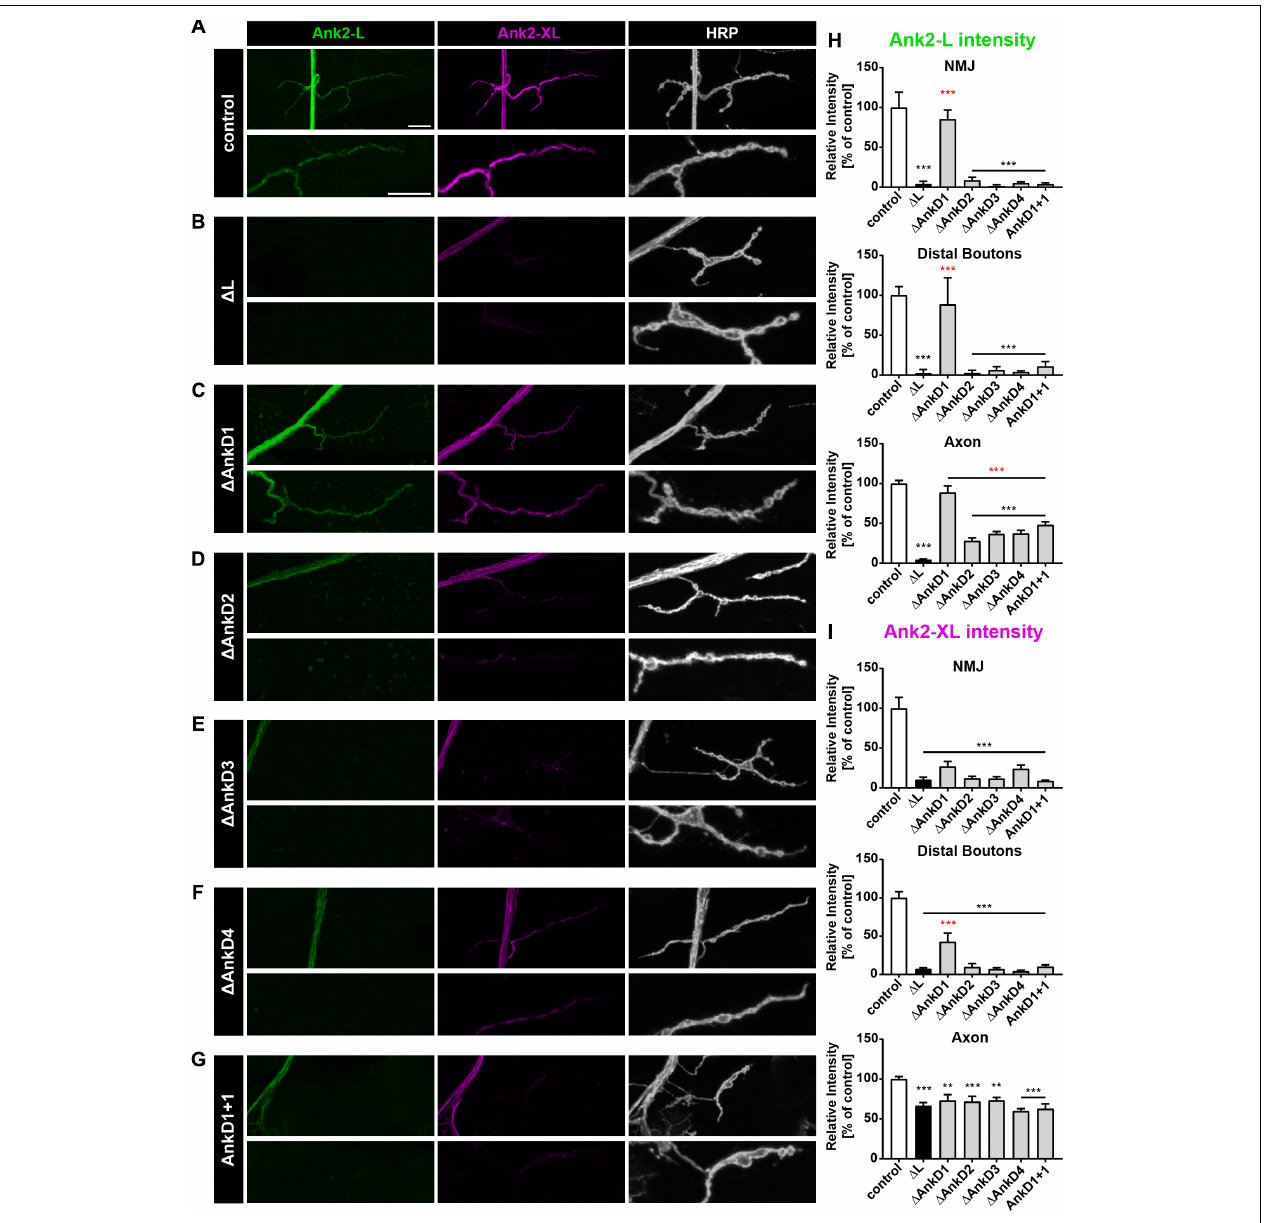
FIGURE 3 | Analysis of ARD-dependent localization of Ank2-L and Ank2-XL in second instar ank2 (cid:49) L mutants. (A–G) Analysis of Ank2-L (green) and Ank2-XL (magenta) localization at muscle 4 NMJs (HRP, white). (A) In control animals ( P[ank2_wt] /+; ank2 (cid:49) L /ank2 null ) Ank2-L and Ank2-XL level are restored compared to ank2 (cid:49) L /ank2 null mutants. (B) In ank2 (cid:49) L /ank2 null mutant animals Ank2-L is absent and levels of Ank2-XL are severely reduced at the NMJ and also in the axon. (C–G) Analysis of the AnkD manipulations ( P[ank2_ (cid:49) AnkDx] /+; ank2 (cid:49) L /ank2 null ) reveals alterations of Ank2-L and Ank2-XL similar to those in third instar mutant larvae. The (cid:49) AnkD1 rescue construct almost completely restores Ank2-L level. All deletion mutations significantly reduce Ank2-XL distribution at the NMJ and in axons. (H) Quantification of Ank2-L level at the NMJ, within distal boutons and in the axon ( n = 11–12 muscle 4 NMJs, three animals/genotype). (I) Quantification of Ank2-XL level at the NMJ, in distal boutons and in the axon ( n = 11–12 muscle 4 NMJs, three animals/genotype). Scale bars in (A) apply to (A–G) and represent 10 µ m. Error bars indicate SEM; ∗∗ p < 0.01, ∗∗∗ p < 0.001 (ANOVA); black asterisks represent comparison to controls; red asterisks represent comparisons to ank2 (cid:49) L